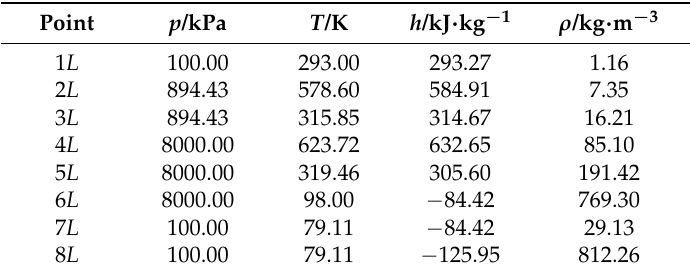
Table 2. Parameters of the points in the air liquefied